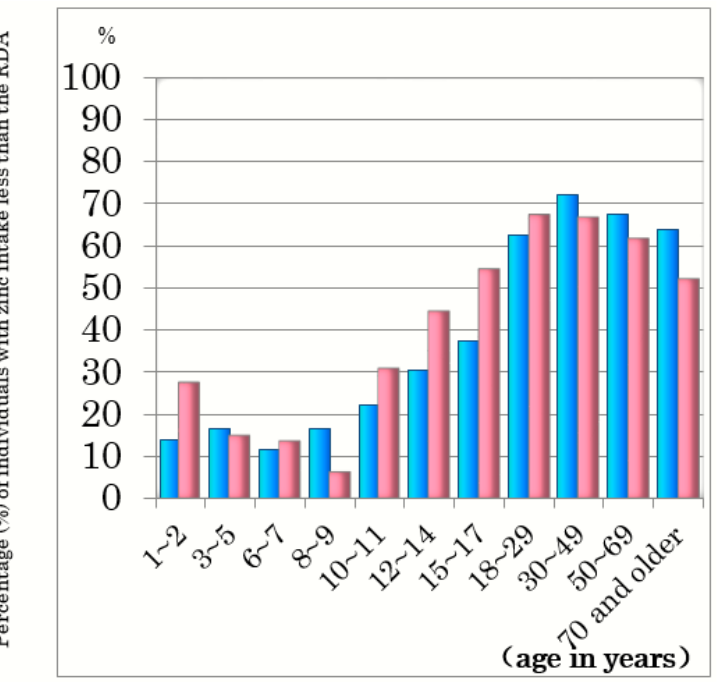
Figure 1. Percentage of people with zinc intake less than the RDA in Japan. The recommended dietary allowance (RDA) of zinc was obtained from the Dietary Reference Intakes for Japanese 2020 [4]. The data for zinc intake were obtained from the National Health and Nutrition Survey 2017 in Japan [5]. The percentage of individuals zinc intake less than the RDA was calculated from the data of RDA (Ref. [4]) and the zinc intake (Ref. [5]). Blue and red bars are those for males and females, respectively.